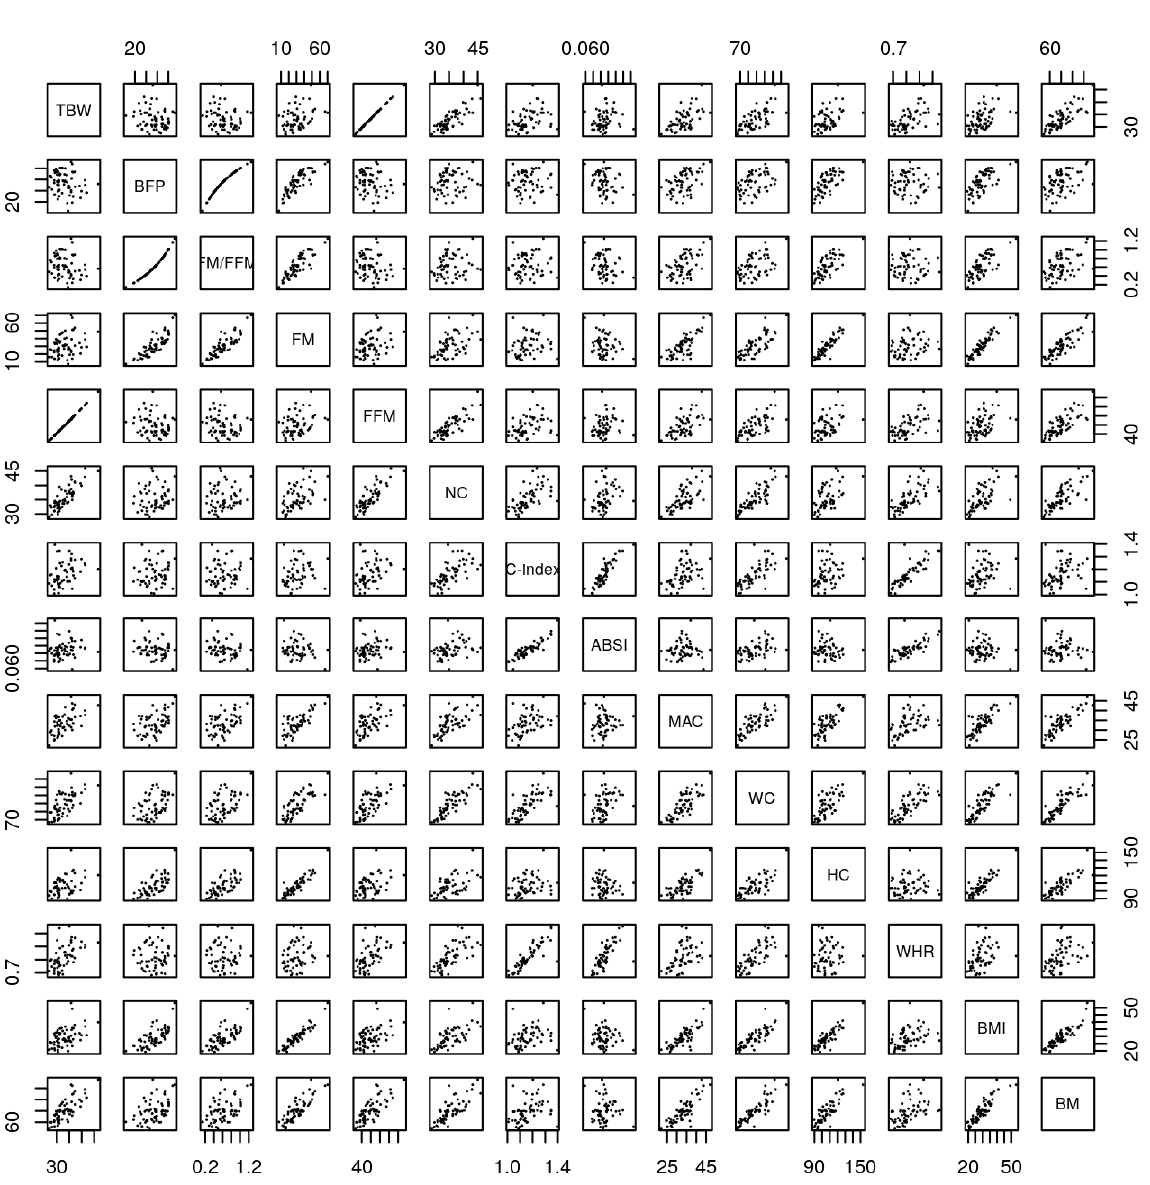
Figure 3. Scatter plot of the variables of the study. TBW—Total body water; FM—Fat mass; BFP—Body fat percentage; FFM—Fat-free mass; BM—Body mass; BMI—Body max index; WHR—Waist-hip ratio; NC—Neck circumference; MAC— Mid-arm circumference; WC—Waist circumference; HC—Hip circumference; C-index—Conicity index; ABSI—A body shape index; FM/FFM—Fat mass/fat-free mass.